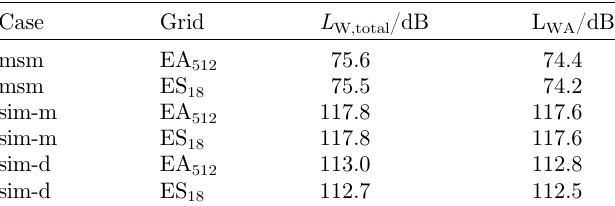
Table 7. Calculated sound power levels.